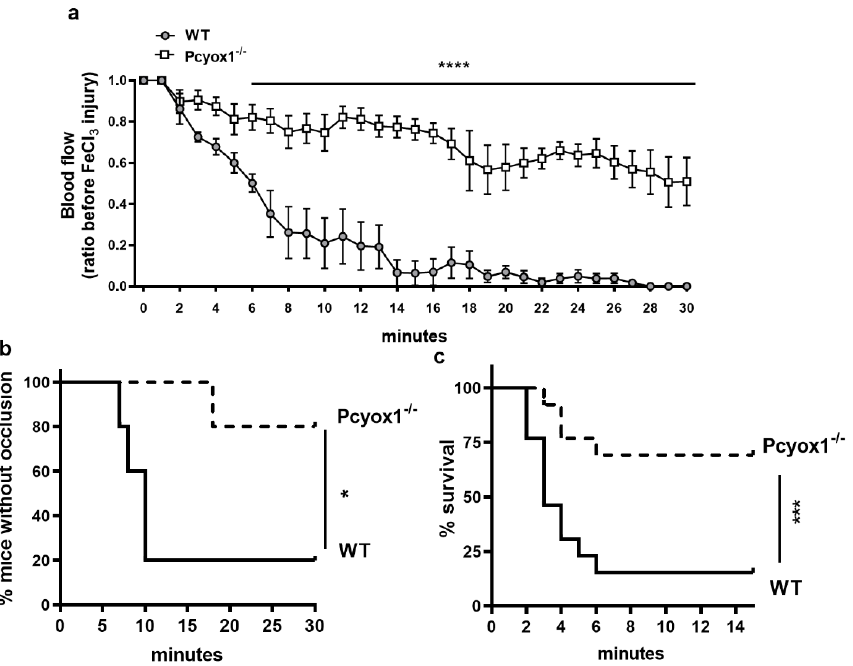
Figure 1. Thrombosis in WT and Pcyox1 − / − mice. ( a , b ) Arterial thrombosis induced by FeCl 3 application to the carotid artery: ( a ) blood flow kinetic in carotid arteries during 30 min of observa- tion was expressed relative to the value before the injury, and ( b ) Kaplan–Meier curve representing percentage of mice without occlusion through recording time. n = 5 mice/group. ( c ) Kaplan–Meier curve representing percentage of mice survived to collagen/epinephrine injection. n = 13 mice/group. ( a ) Data are shown as mean ± SEM. Two-way ANOVA with repeated measures followed by Bonfer- roni post hoc analysis p value were obtained by using log-transformed variables, and ( b , c ) p -values were obtained by analysing Kaplan–Meier curves by Log-Rank tests. * p < 0.05, *** p < 0.005 and **** p < 0.001.